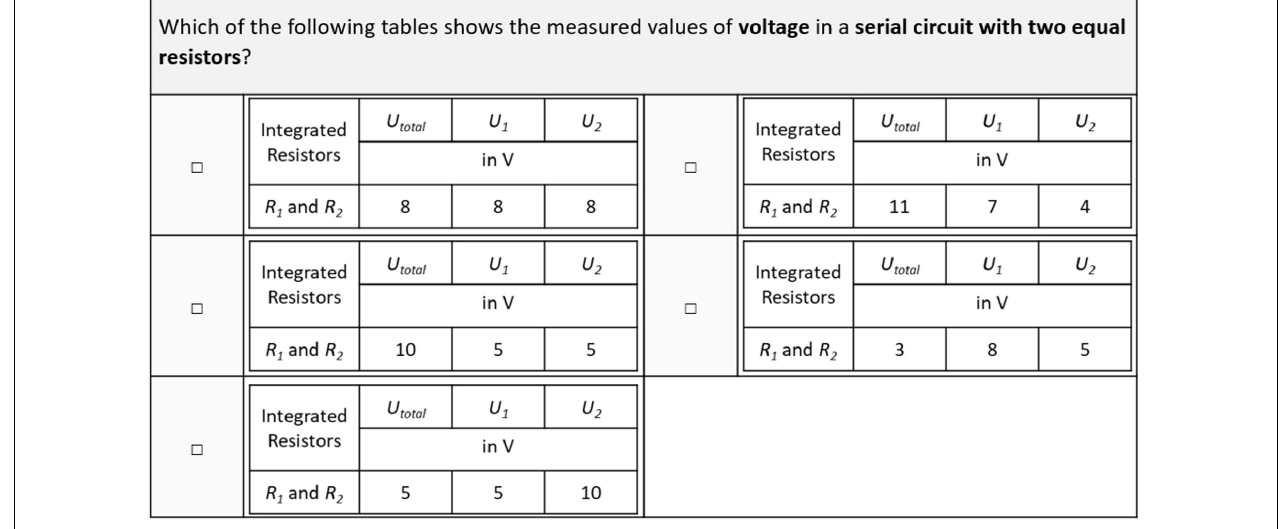
FIGURE 6 | Exemplary item on specific knowledge on the behavior of measurement data (translated for this manuscript).